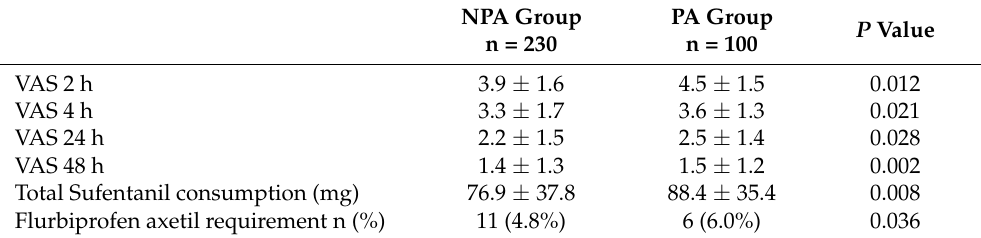
Table 3. Postoperative pain.